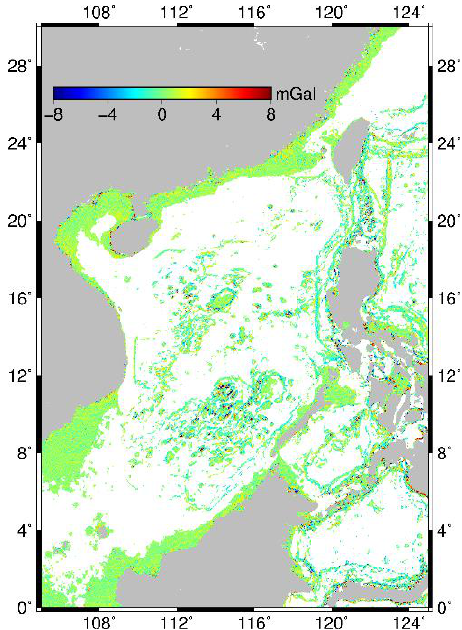
Figure 6. Differences between SCSGA V1.2 and SCSGA V1.0. Table 11. Differences between SCSGA V1.2 and SCSGA V1.0 in different areas (in mGal). Depth (m)